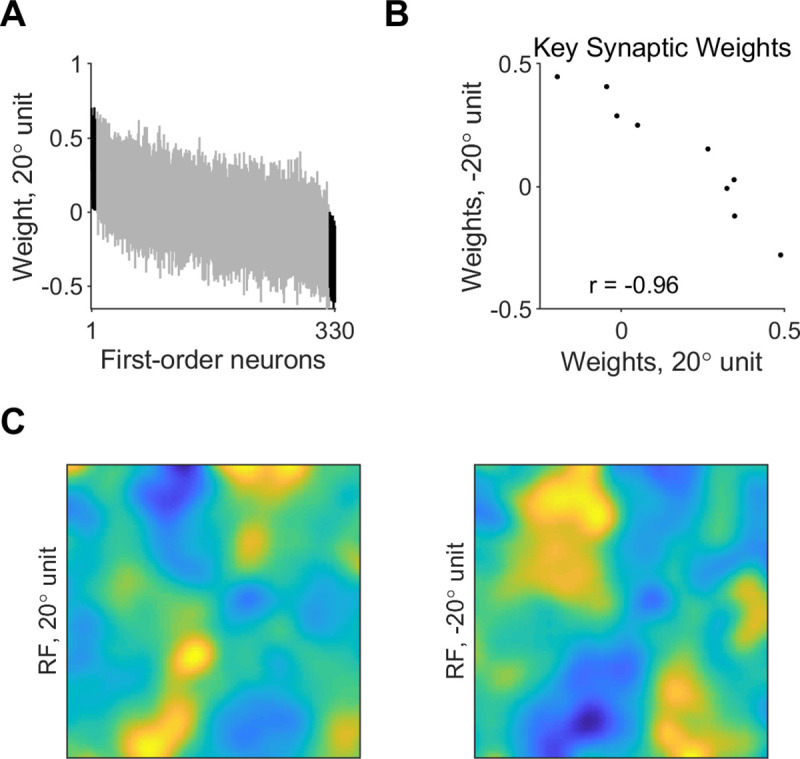
Synaptic weights and receptive field of edge-orientation classifiers integrating fast-decaying (AMPA) inputs.A. Synaptic weights from model first-order neurons onto classifier units using fast-decaying (AMPA) synapses and tuned to 20°, with a presentation time window of 50 ms and noise level 5%. Shown are 95% confidence intervals of weights over 20 classifiers. Synaptic weights are shown in decreasing order of average weight over the 20 classifiers. Black–key synaptic weights, which were significantly different than 0. B. Key excitatory synaptic weights in example classifier units using AMPA synapses and tuned to 20 vs -20°. C. Spatial layout of the synaptic weights in classifier units using AMPA synapses and tuned to -20 or 20°, with a presentation time window of 50 ms and noise level 5%. Receptive fields represent averages over 20 classifiers.